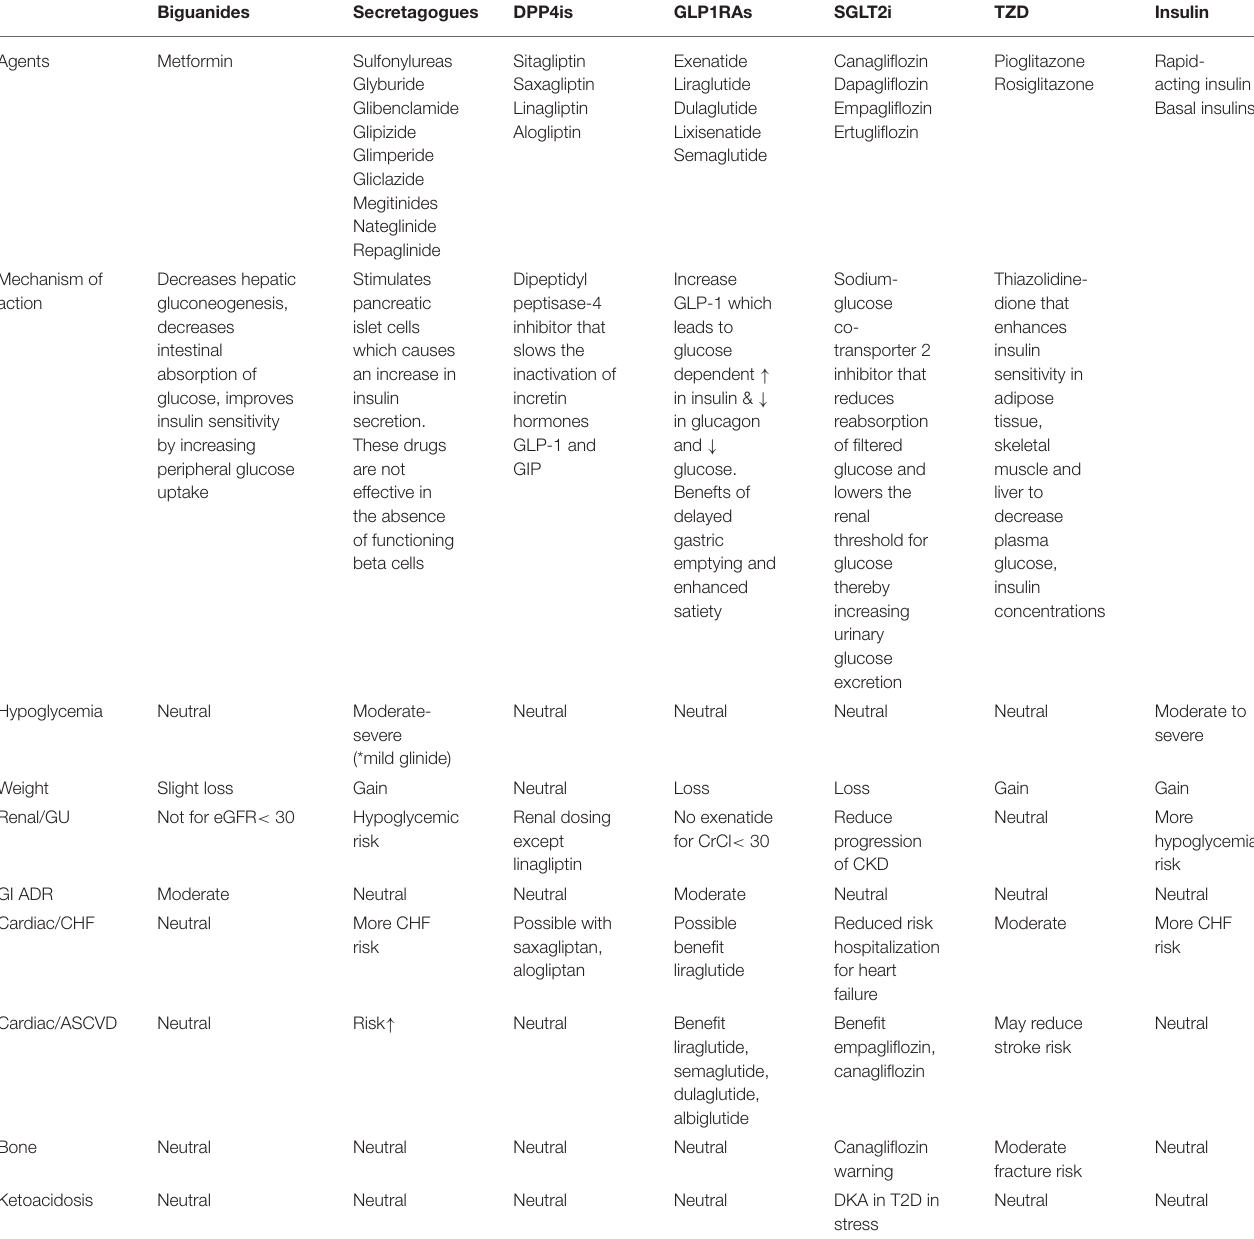
TABLE 2 | Summary of type 2 diabetes medication benefits/risks (1, 23,